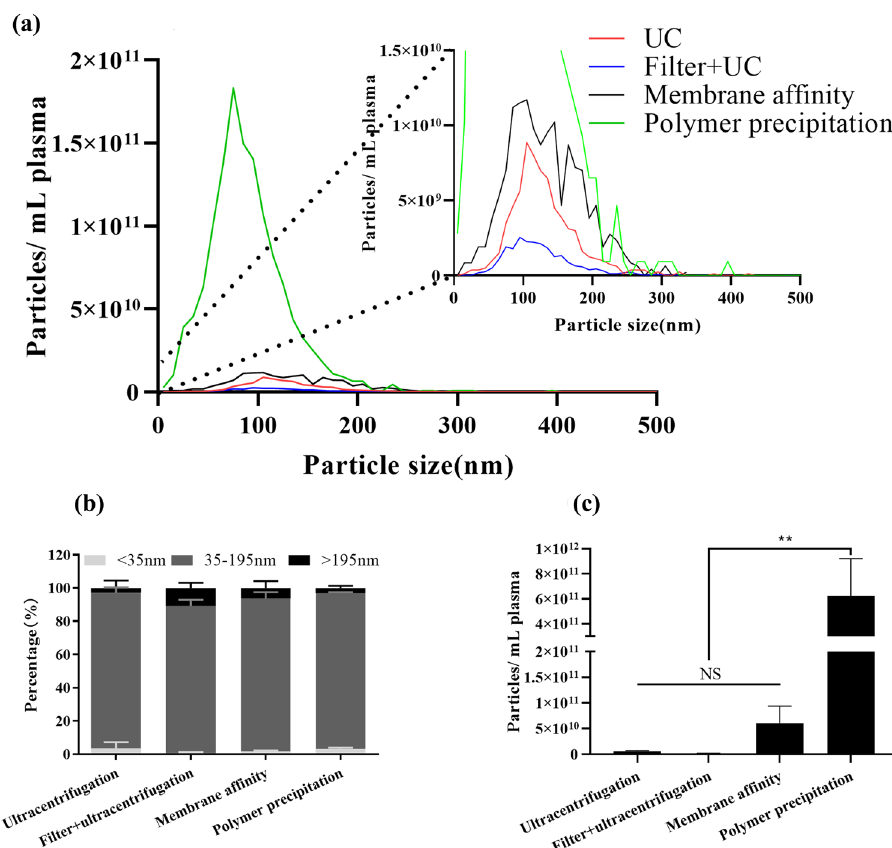
Figure 3: Size distribution and concentration of exosomes enriched with di ff erent isolation procedures. ( a ) Particle size for plasma exosomes measured by nanoparticle tracking analyses ( NTA ) . Insets depict higher magni fi cations of the black dot box areas. ( b ) Size distribution as a percentage of vesicles larger than 195 nm ( black ) , between 35 and 195 nm ( gray ) and smaller than 35 nm ( white ) based